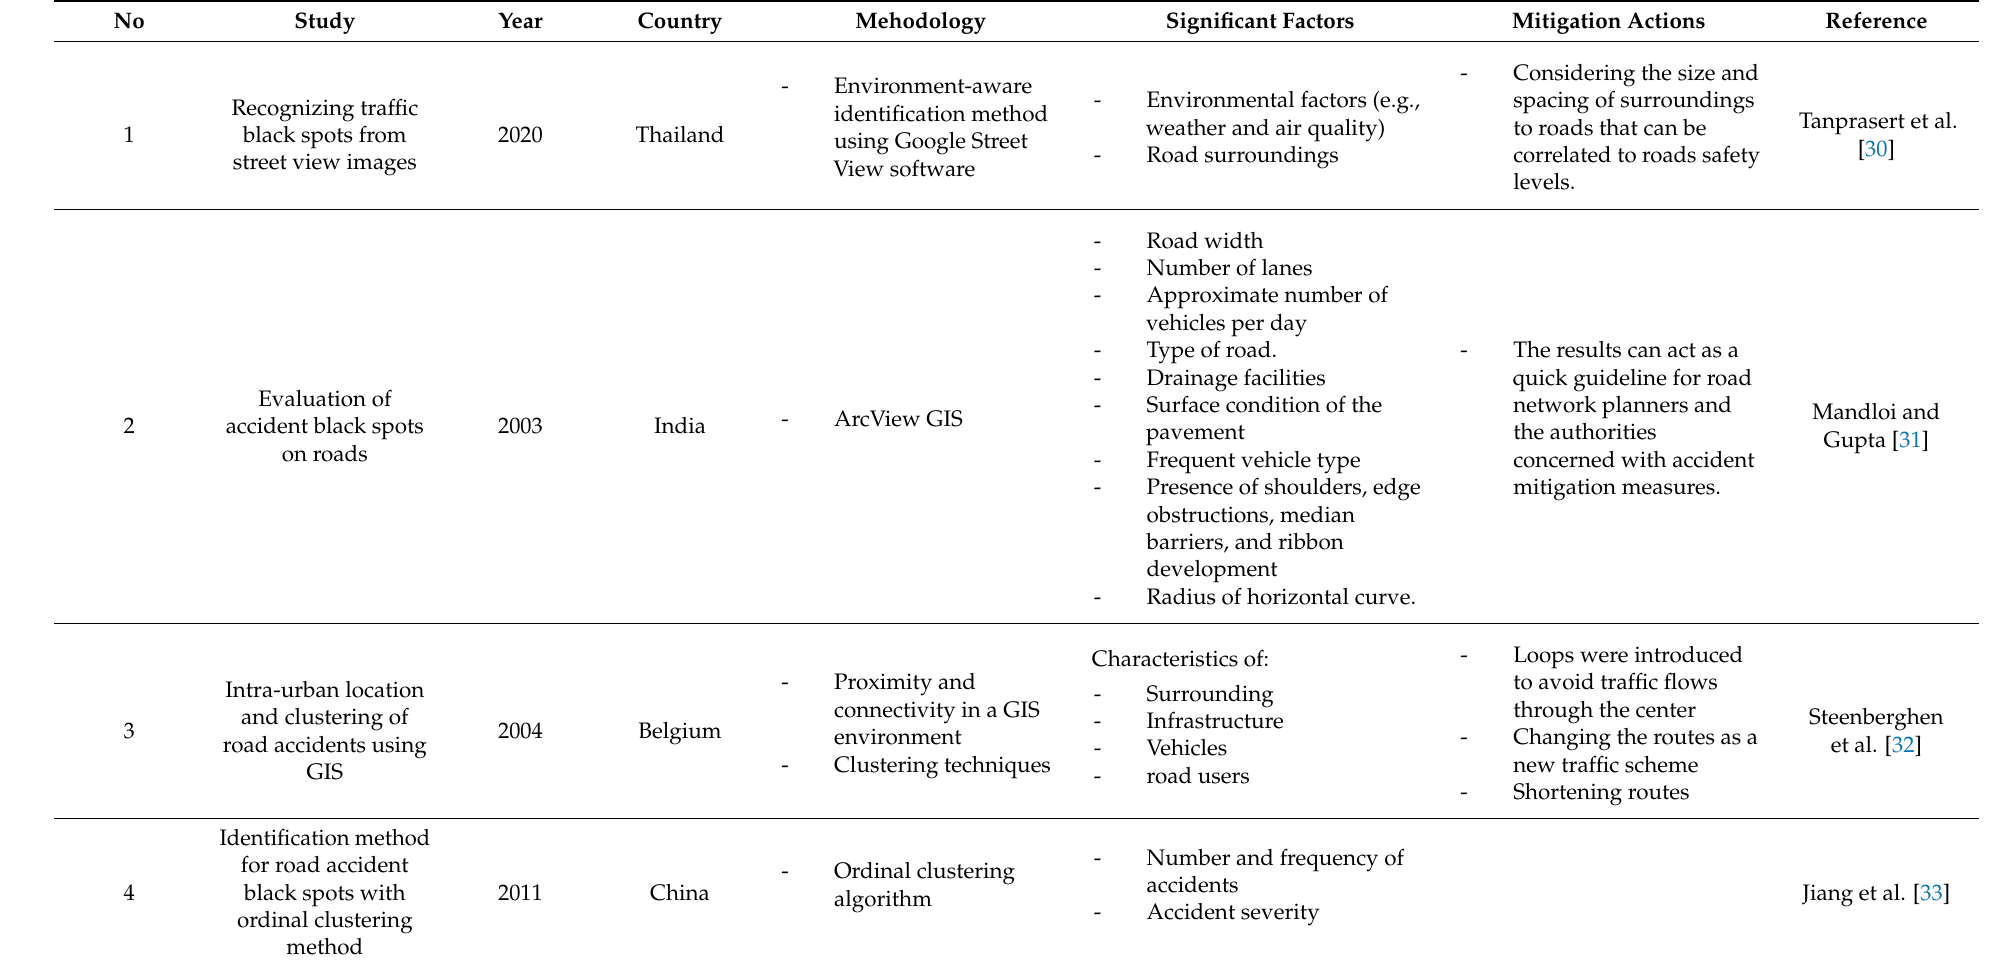
Table 1. Summary of past studies on hotspot identification and road